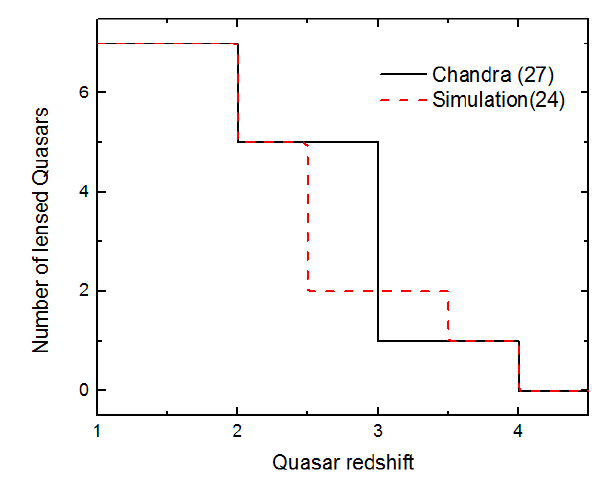
Figure 2. Histogram of the redshift distributions for 24 synthetic lensed Quasars (dashed line) and 27 lensed Quasars observed by Chandra (continuous line).